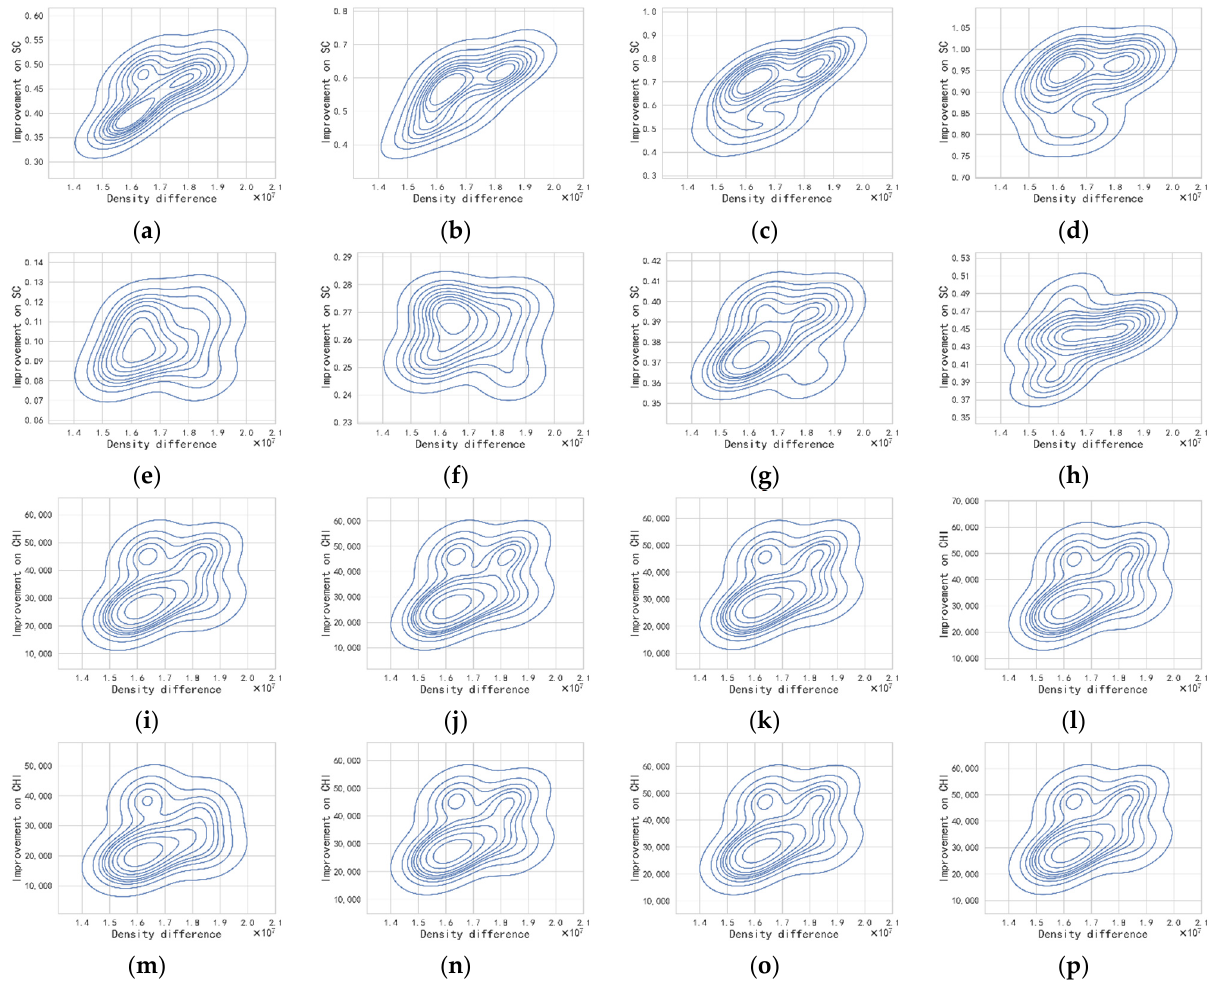
Figure 14. Influence of density difference on the improvements of ELV compared with other methods on two indicators, namely: improvement on SC compared with ( a ) DBSCAN 200, ( b ) DBSCAN 400, ( c ) DBSCAN 800, ( d ) DBSCAN 1600, ( e ) HDBSCAN 4, ( f ) HDBSCAN 8, ( g ) HDBSCAN 16, and ( h ) HDBSCAN 32; improvement on CHI compared with ( i ) DBSCAN 200, ( j ) DBSCAN 400, ( k ) DBSCAN 800, ( l ) DBSCAN 1600, ( m ) HDBSCAN 4, ( n ) HDBSCAN 8, ( o ) HDBSCAN 16, and ( p ) HDBSCAN